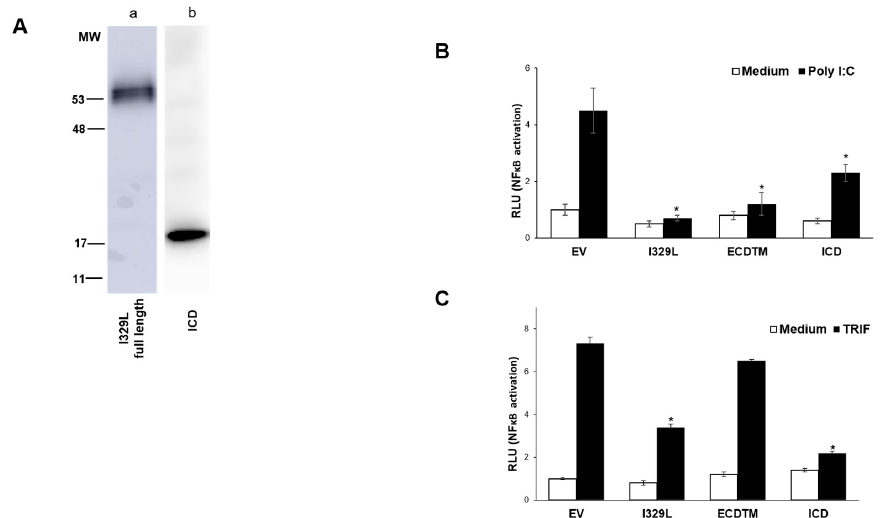
Figure 7. The ICD of I329L inhibits induction of type I IFN at the level of TRIF. ( A ) HEK-293T cells were transfected with different HA-tagged I329L constructs and expression was confirmed by Western blot using an anti-HA HRP-conjugated antibody: (a) full length I329L, (b) the intracellular domain (ICD). ( B ) HEK-293T cells were co-transfected with either pcDNA3HA (EV), pcDNA3-I329L-HA, or pcDNA3-ICD-HA, the IFN- β luciferase reporter and the β -galactosidase internal control plasmid. Cells were either stimulated with 25 μ g/mL Poly(I:C) (TLR3 ligand) or left untreated (medium). ( C ) Luciferase activity was determined in HEK-293T cells co-transfected with pcDNA3HA (EV) or pcDNA3-I329L-HA, or pcDNA3-ECDTM-HA, or pcDNA3-ICD-HA, the IFN- β luciferase reporter and the β -galactosidase internal control plasmid. Cells were either induced with ectopically expressed TRIF or left untreated (medium). Luciferase activity was normalized to β -galactosidase activity. Data are expressed as means of relative luciferase units (RLU) ± SD of triplicate culture wells and are representative of three independent experiments. RLU ratios quantifying changes between activation vs. untreated conditions for each of the constructs were compared against EV ratios and assessed by Student’s t test. * p ≤ 0.05.